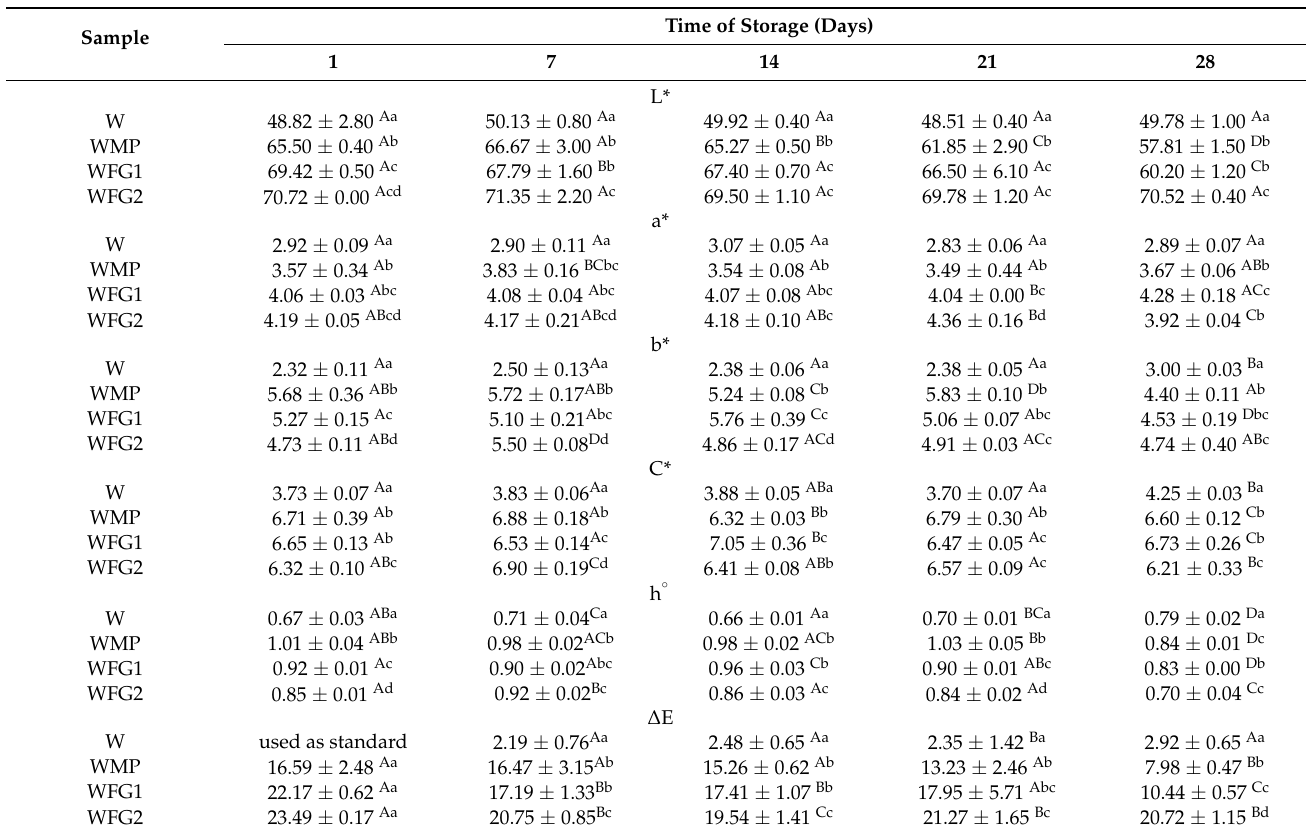
Table 5. Color changes of the samples during storage